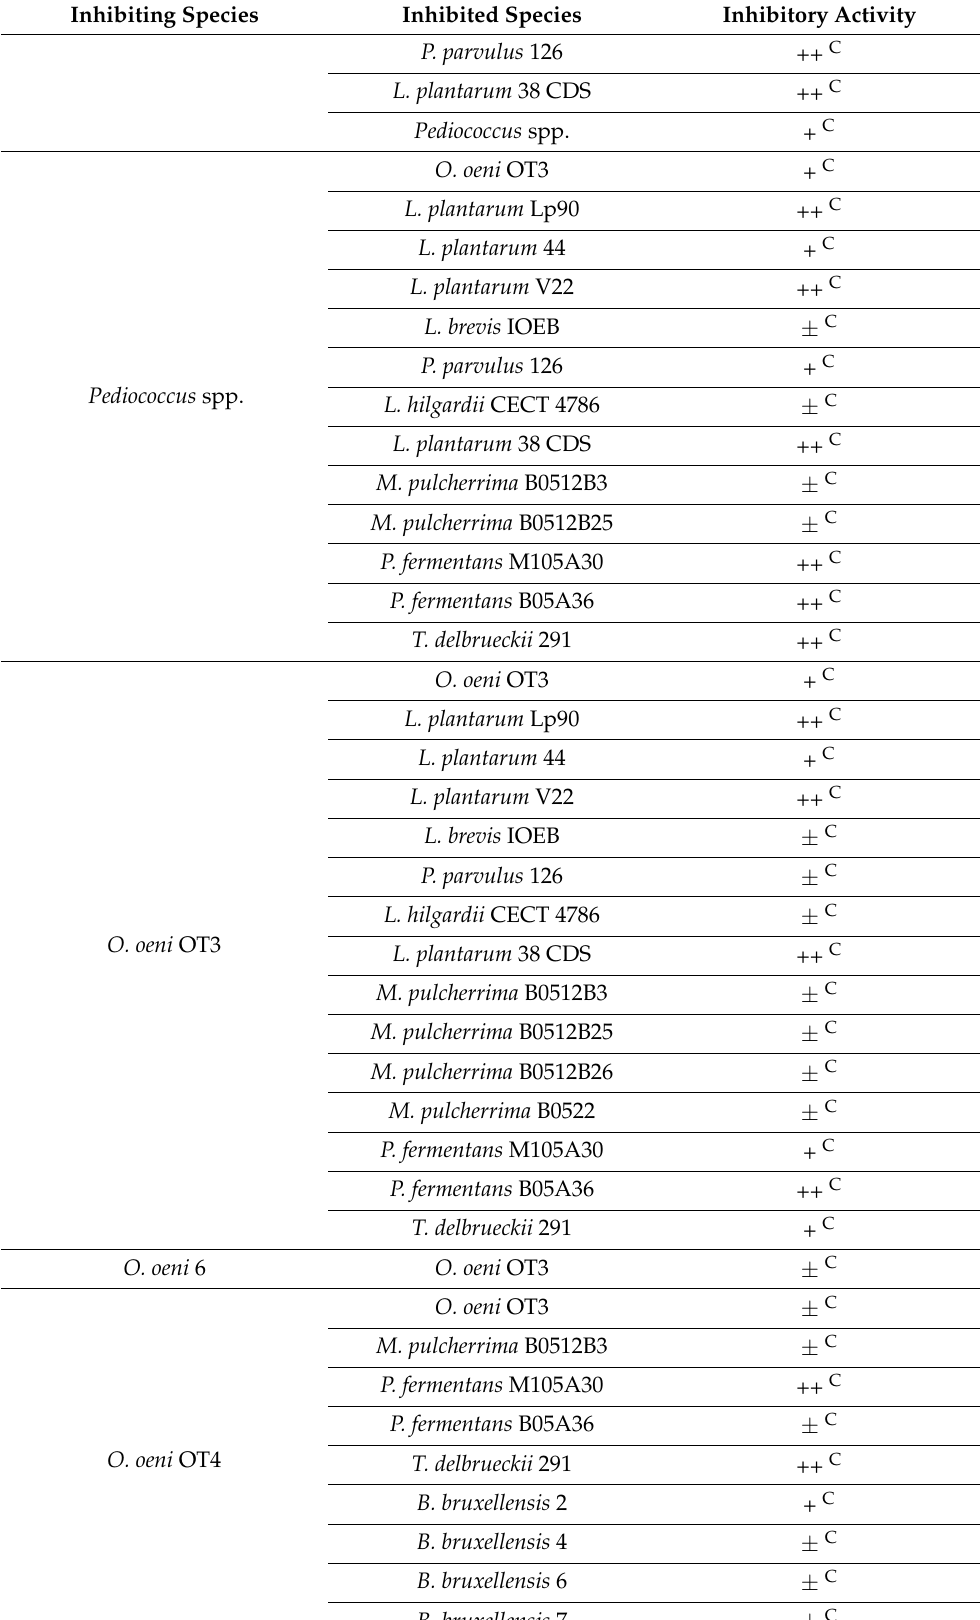
Table 4. Cont. Inhibiting Species Inhibited Species Inhibitory